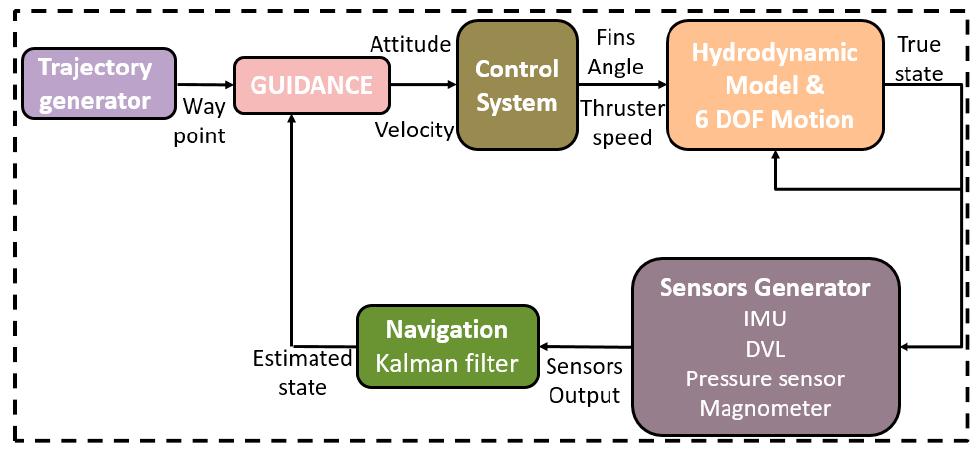
Figure 2. Technion autonomous underwater vehicle six degrees of freedom (TAUV 6 DOF) simulation layout. IMU: inertial measurement unit.